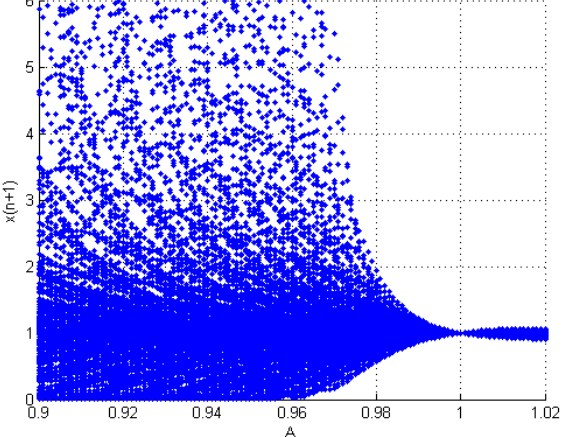
Figure 1. Bifurcation diagram of Equation (9) in ( A , x )